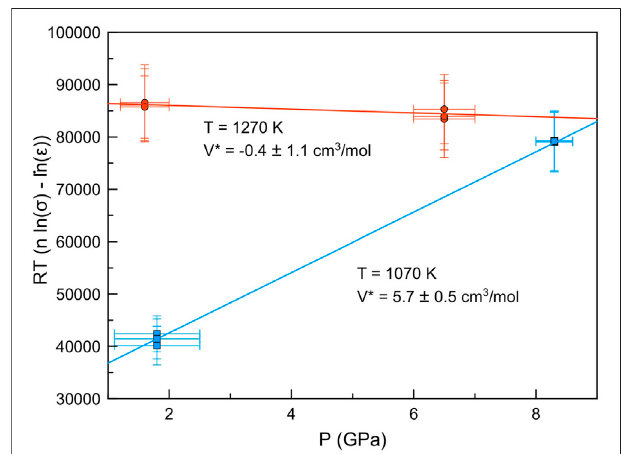
FIGURE 12 | Activation volume of polycrystalline MgO in the diffusion regime at 1,270 K (Runs D2029 and D2032, red circles) and the dislocations- dominated regime at 1,070 K (Runs D2324 and D2325, blue squares). Errors bars are ±1 σ uncertainties deduced from the experimental results. Reported errors on the activation volume are 1 σ uncertainties deduced from a Monte Carlos